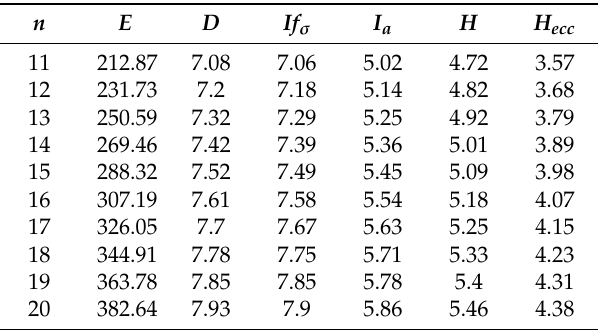
Table 6. The graph energy and five types of entropies applied to A 12 n + 4 .